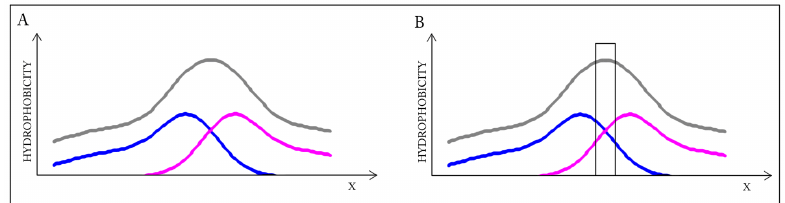
Figure 2. Schematic depiction of a system in which individual monomers lack hydrophobic cores but the dimer as a whole contains a well-defined core. Elimination of residues involved in complexation distorts the dimeric core while bolstering the monomeric cores—The black frame (right-hand schema) symbolizes the interface, which has been eliminated from RD calculation to characterize its influence on the status of the dimer, as well as the status of each monomer. Blue and pink lines: distributions in monomers, gray line: distribution in dimer. ( A ) Status of the individual monomers ( blue and pink ) versus the resultant distribution in dimer ( gray ); ( B ) the removal of the interface ( black bar ) does not change the status of the dimer—Distribution accordant versus the expected one.